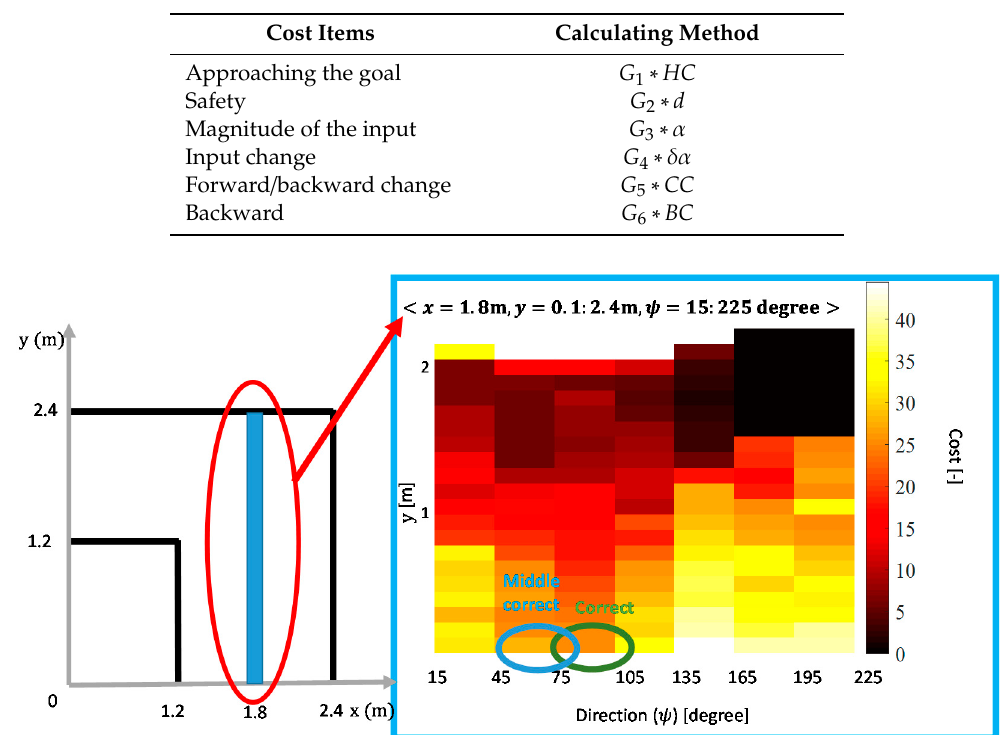
Table 2. Items for the cost function in HA* to calculate the predicted reward.